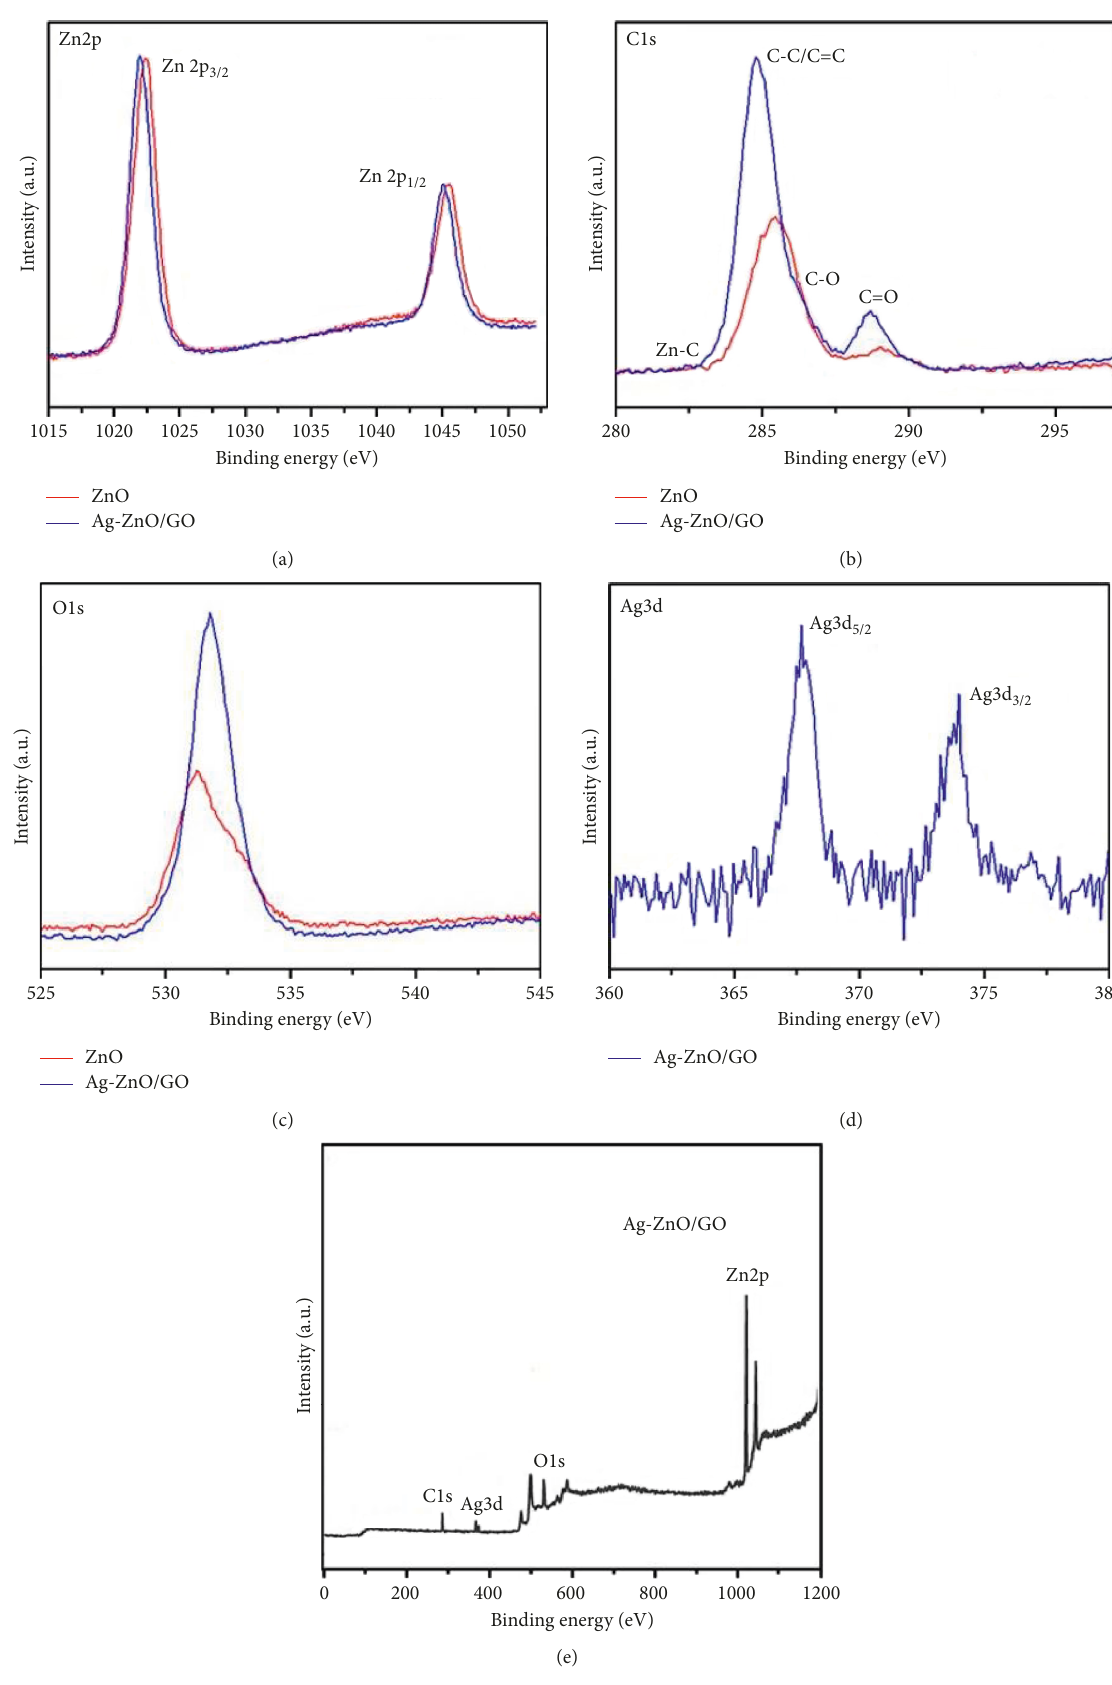
Figure 4: XPS analyses of synthesized